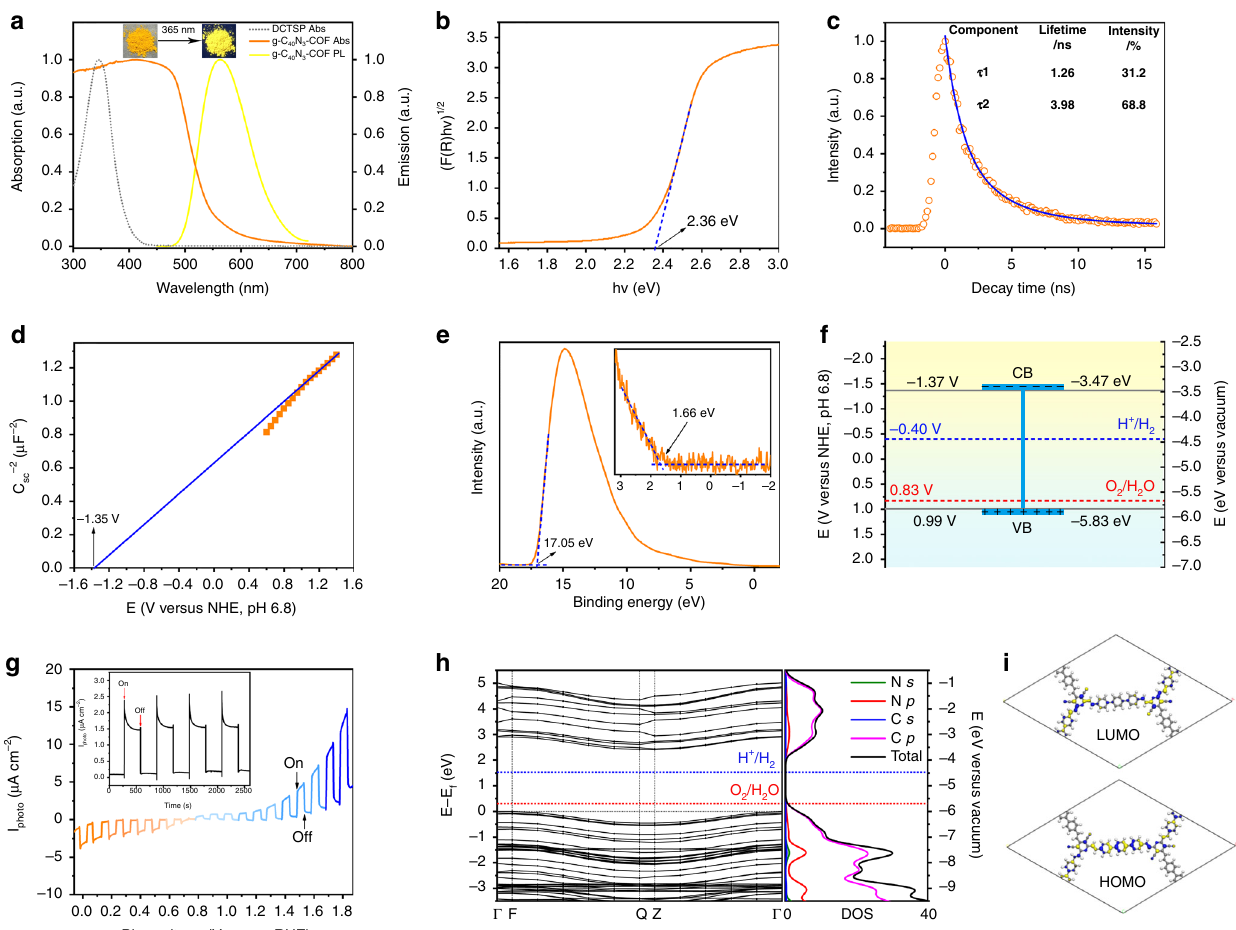
Fig. 5 Optical and electronic properties of g-C 40 N 3 -COF. a UV/vis diffuse re fl ectance spectra (DRS) and steady-state photoluminescence (PL) spectra of g-C 40 N 3 -COF. The gray dash line represents solution UV/vis absorption spectra of DCTSP (model compound) recorded in dichloromethane. The upper inset shows the digital photograph of the sample under ambient light and 365nm UV-lamp. b Band gap determined from the Kubelka – Munk-transformed re fl ectance spectra. c PL decay spectra monitored at 563nm under 365nm excitation at 298K. d Mott-Schottky (M-S) plot for g-C 40 N 3 -COF measured in 0.2M Na 2 SO 4 (pH 6.8) with Ag/AgCl ( + 0.199V vs. NHE) as the reference electrode in dark. e UPS spectrum of g-C 40 N 3 -COF. f Band positions of g-C 40 N 3 -COF (These vacuum level values were converted to electrochemical potentials according to: − 4.44eV vs. vacuum level is equal to − 0.4V vs. NHE at pH 6.8). g Chopped current – potential (I – V) curve of g-C 40 N 3 -COF photoelectrode under visible light (300W Xenon light with cut-off fi lter λ >420nm). Electrolyte: Ar-saturated 0.2M Na 2 SO 4 aqueous solution. The applied potential was swept at + 10mVs − 1 under intermittent irradiation with a period of 5s. Inset is chopped anodic photocurrent density vs. time recorded on a g-C 40 N 3 -COF photoanode at 1.0V vs. RHE. h Electronic properties of g-C 40 N 3 -COF using DFT calculations and corresponding density of states (DOS). i The Kohn-Sham orbitals of HOMO and LUMO of g-C 40 N 3 -COF. C gray, N blue, H